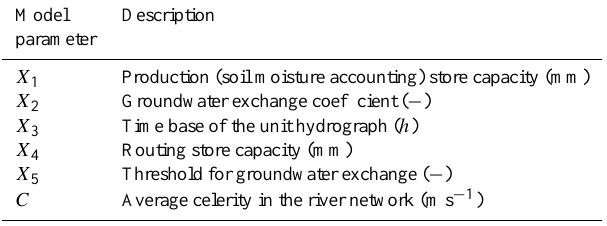
Table 1. Summary of physiographical and hydrometeorological characteristics of the catchment set. The rainfall intensity coefficient is the ratio between the 99th percentile P 99 and the mean hourly precipitation P m .